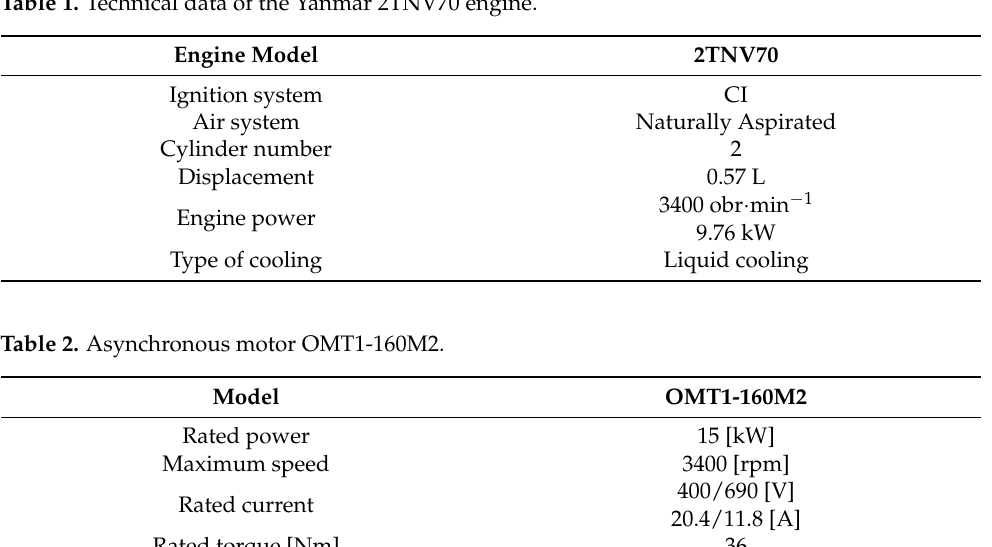
Table 1. Technical data of the Yanmar 2TNV70 engine.